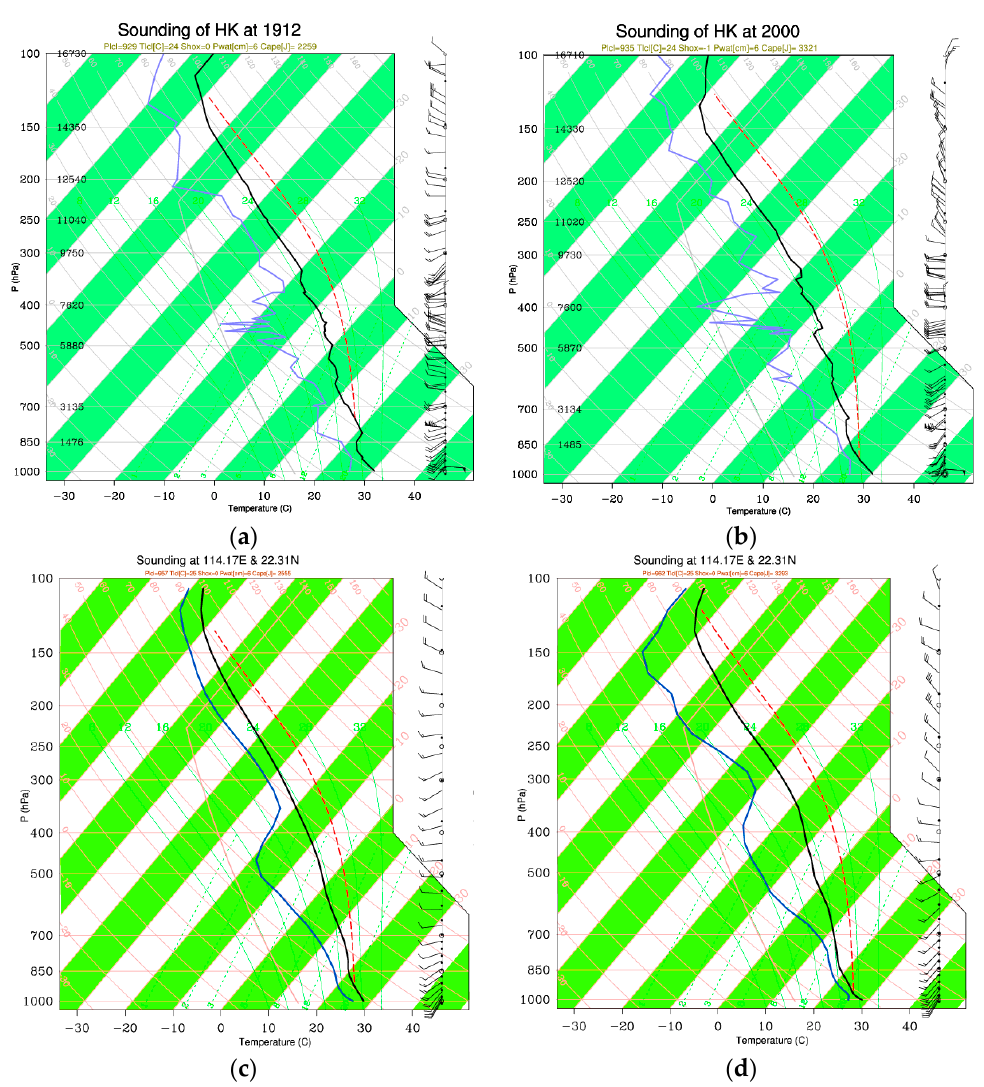
Figure 10. Comparison of the vertical profiles of skew on a T-log P diagram of the temperature (black line), dew point temperature (blue line), and ascending curve of a near surface air parcel (green line) over the Hong Kong sounding for ( a , b ) the observation and ( c , d ) the D4 simulation at ( a , c ) 1200 UTC on 19 May and at ( b , d ) 0000 UTC on 20 May.